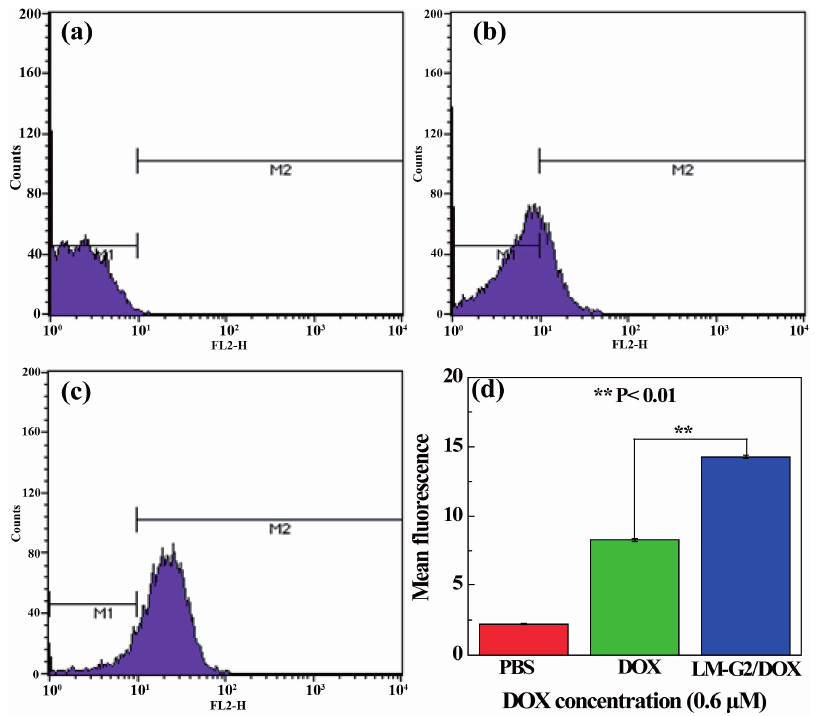
Figure 10. Flow cytometric (FCM) analysis of the in vitro cellular uptake of KB cells treated with ( a ) PBS (control), ( b ) free DOX and ( c ) LM-G2/DOX nanodisks for 2